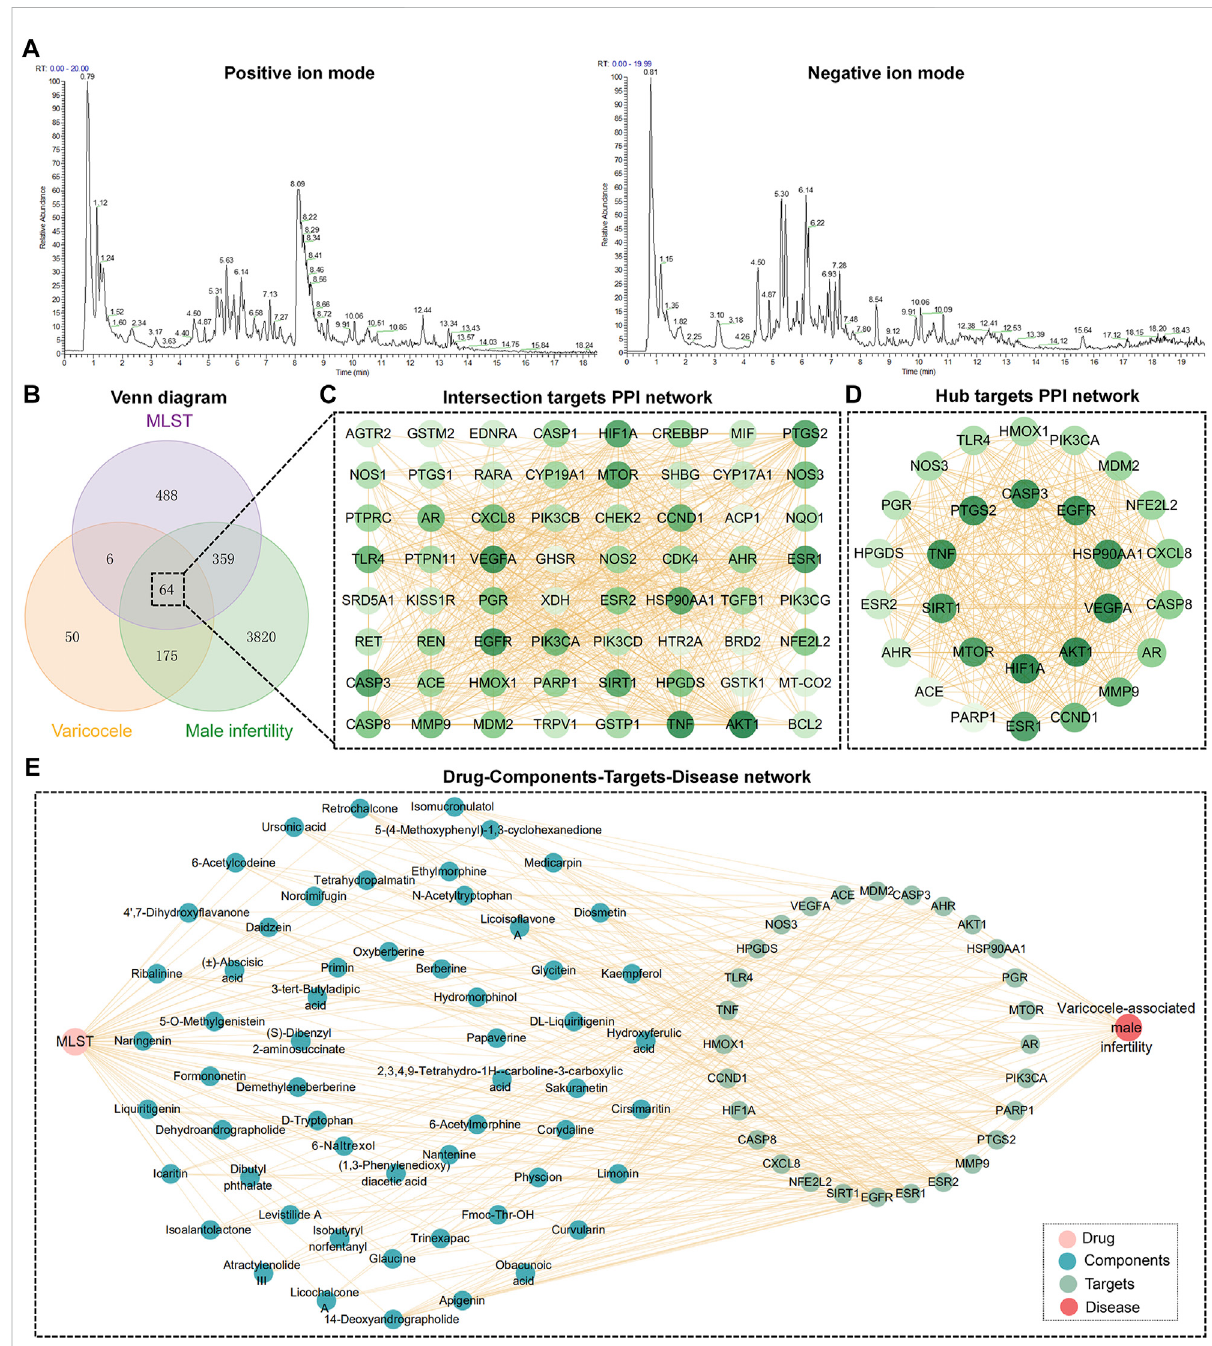
FIGURE 2 NetworkanalysisofMLSTagainstvaricocele-associatedmaleinfertility. (A) Totalion fl owdiagramofcomponentsinMLSTanalyzedbyUHPLC- MS/MS, including positive and negative ion modes. (B) Venn diagram of potential targets in MLST for varicocele-associated male infertility. (C,D) Intersection targets and hub targets PPI network, the darker the color of the node, the larger the degree value. (E) Drug-Components-Targets- Disease